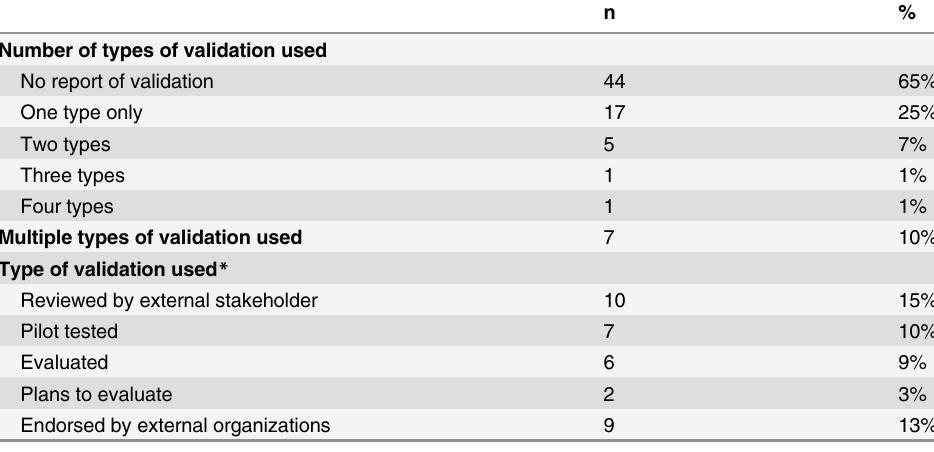
Table 3. Validation of the Reponses to Elder